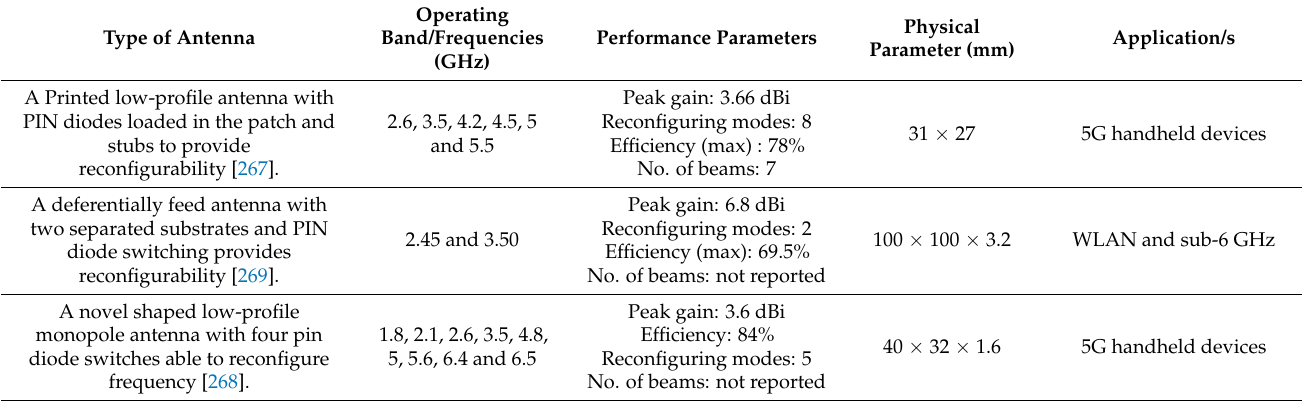
Table 13. Overview of proposed single antenna element systems for sub-6 GHz